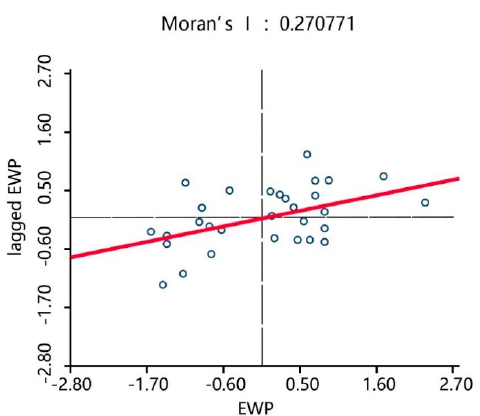
Figure 8. Moran ’s EWP scatterplots of the 30 provinces in 2006.